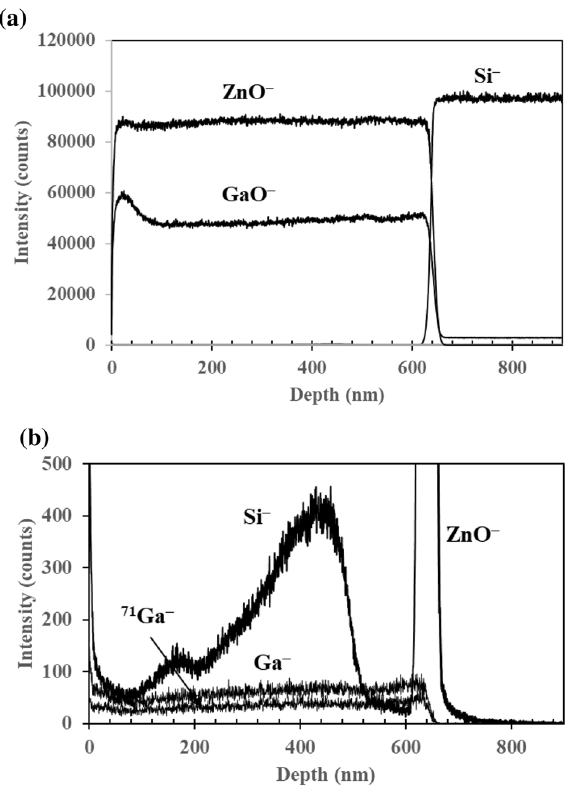
Figure 5. Depth profile analysis of ( a ) high intensity ZnO ‒ , GaO ‒ and Si ‒ ion fragments and ( b ) low intensity Si ‒ , Ga ‒ and 71 Ga ‒ ion